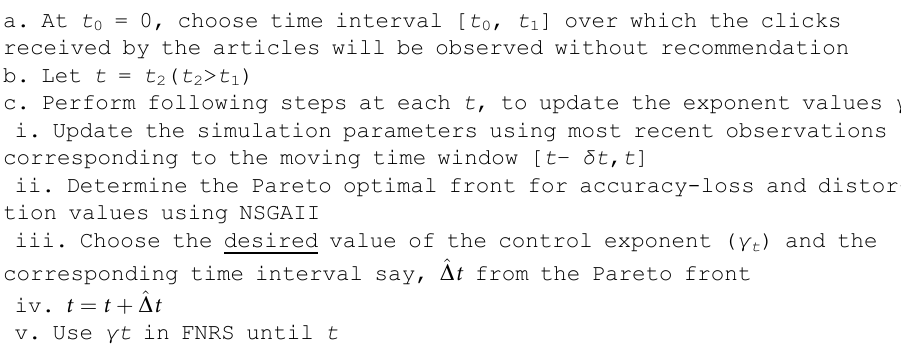
Algorithm 2: Pseudo code to dynamically update the exponent